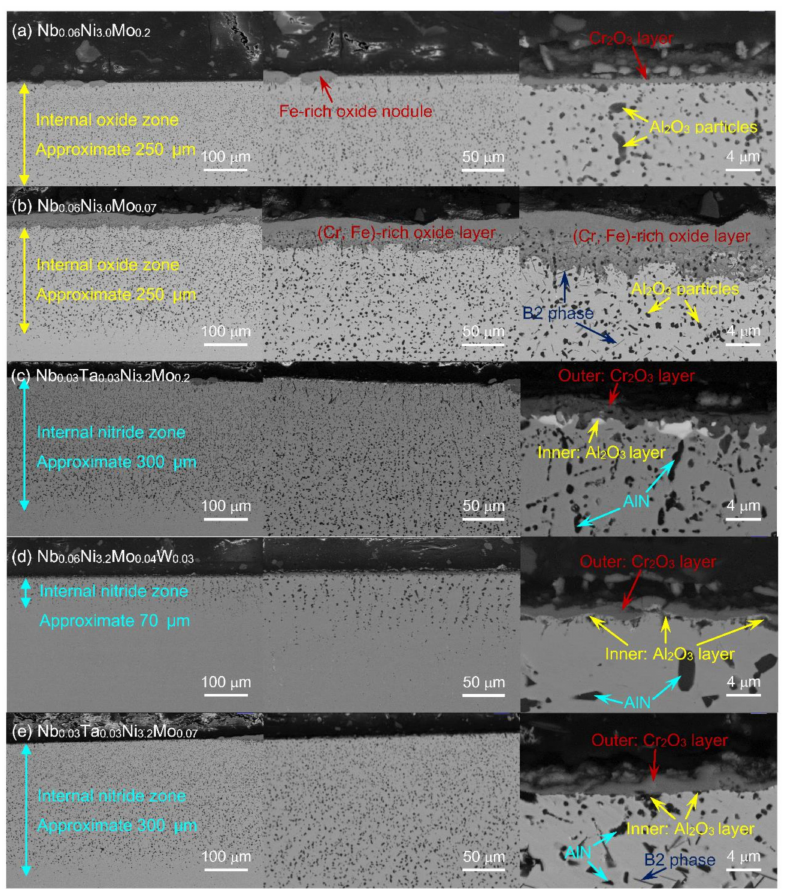
Figure 9. SEM back-scattered electron cross-section images of oxide layers after 200 h oxidation at 800 ◦ C of series-2 alloys. ( a ): Nb 0.06 Ni 3.0 Mo 0.2 , ( b ): Nb 0.06 Ni 3.0 Mo 0.07 , ( c ): Nb 0.03 Ta 0.03 Ni 3.2 Mo 0.2 , ( d ): Nb 0.06 Ni 3.2 Mo 0.04 W 0.03 , ( e ): Nb 0.03 Ta 0.03 Ni 3.2 Mo 0.07